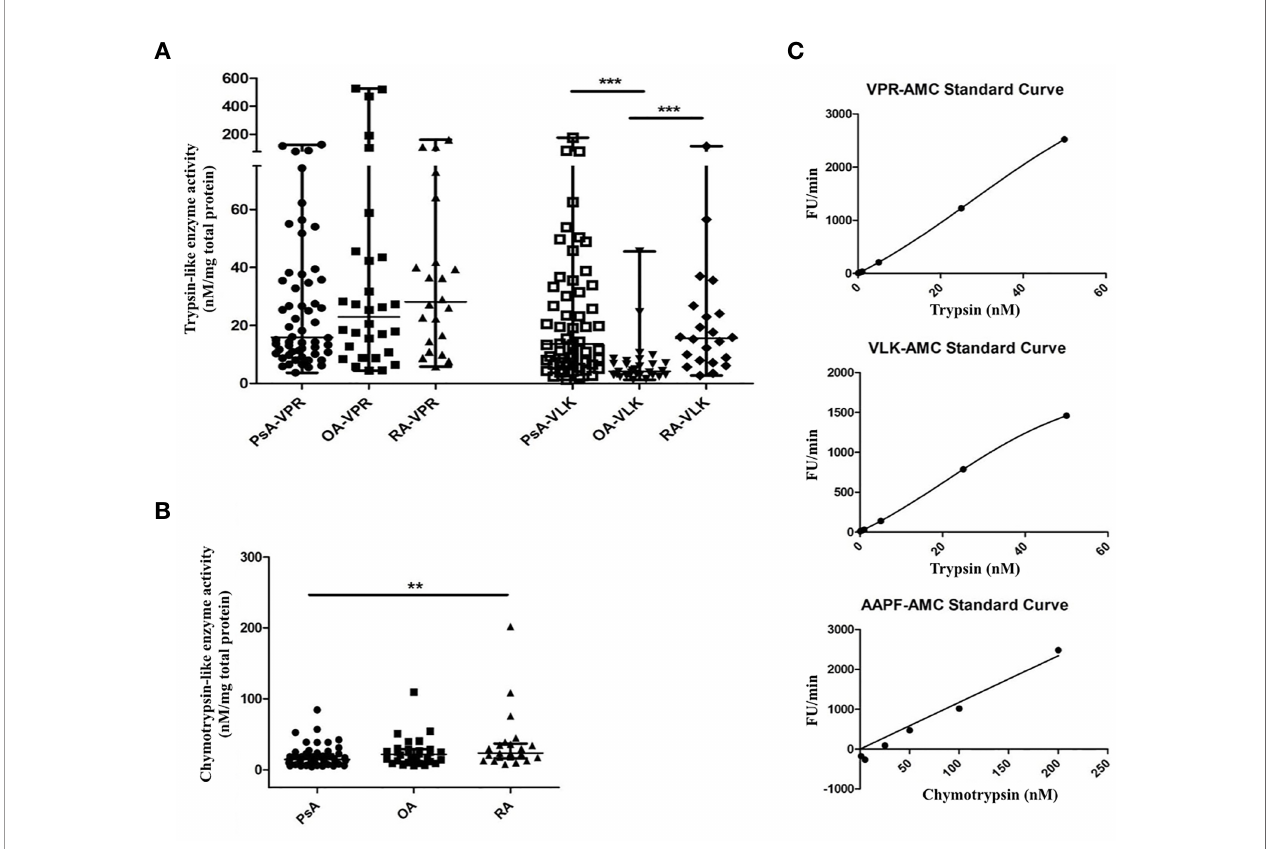
FIGURE 3 | Serine proteinase activity in SF from PsA, RA and OA patients. Serine proteinase activity using fl uorogenic substrates for trypsin-like proteinases with a preference for arginine (VPR) or lysine (VLK) (A) and chymotrypsin-like proteinases (B) is shown. Fluorescence release was monitored for 20 min of a kinetic cycle and the slope of the resulting curve was extrapolated relative to a standard curve of fl uorescence release by known concentrations of either trypsin or chymotrypsin and normalized to the total protein concentration of the sample. Representative standard curves are shown in (C) for each substrate. Groups were compared using the Kruskal-Wallis test with Dunn ’ s multiple comparisons test. Asterisks are used to indicate signi fi cant differences between groups, where **p<0.01 and